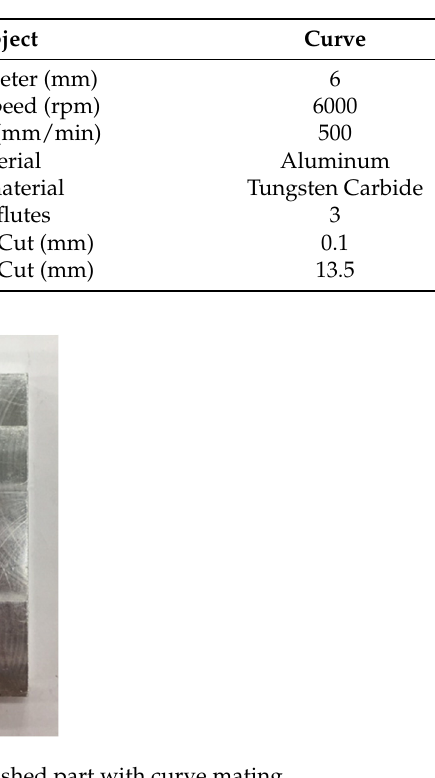
Table 1. Cutting parameters for experiment verification.